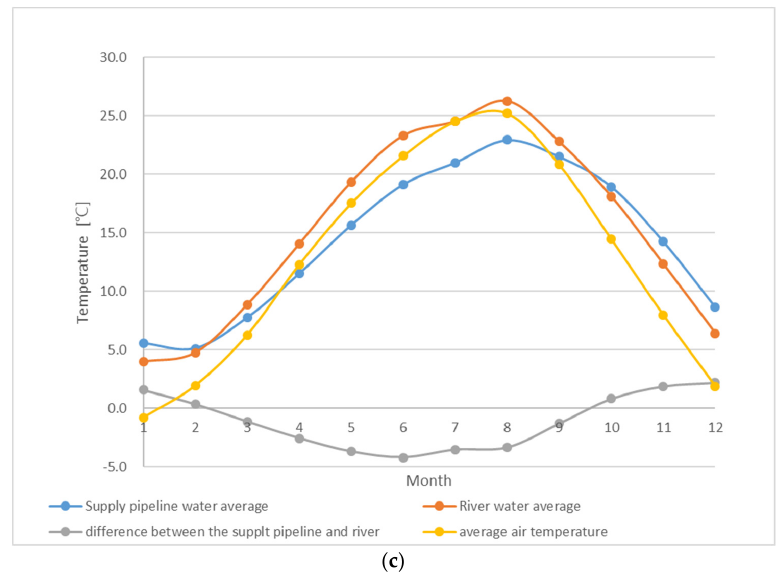
Figure 2. Hydrothermal sources of ( a ) river water, ( b ) pipeline water, and ( c ) monthly mean temperature of pipeline water, river water, and standard meteorological data.